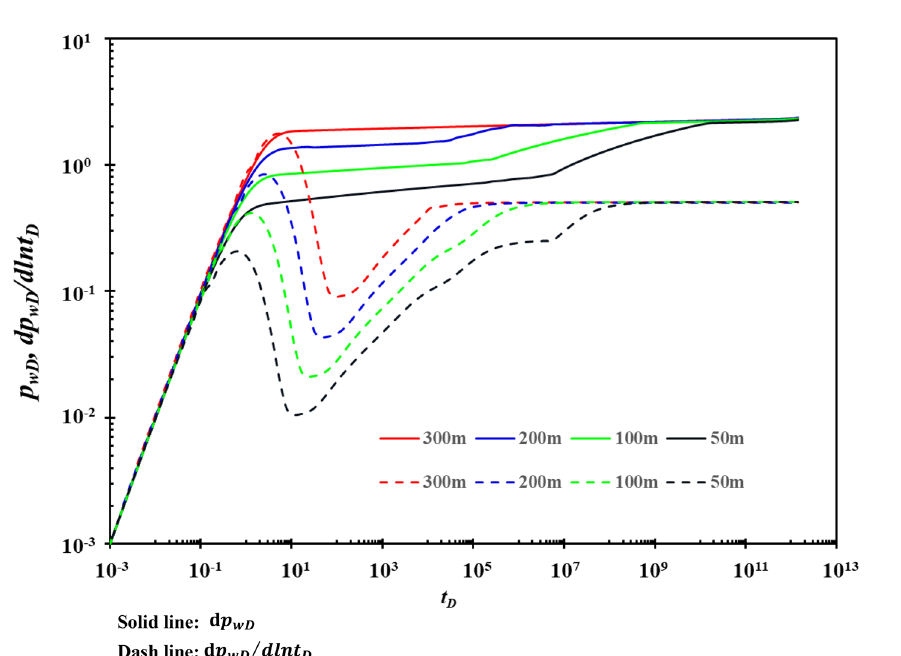
Figure 16. The effect of fracture half-length on type